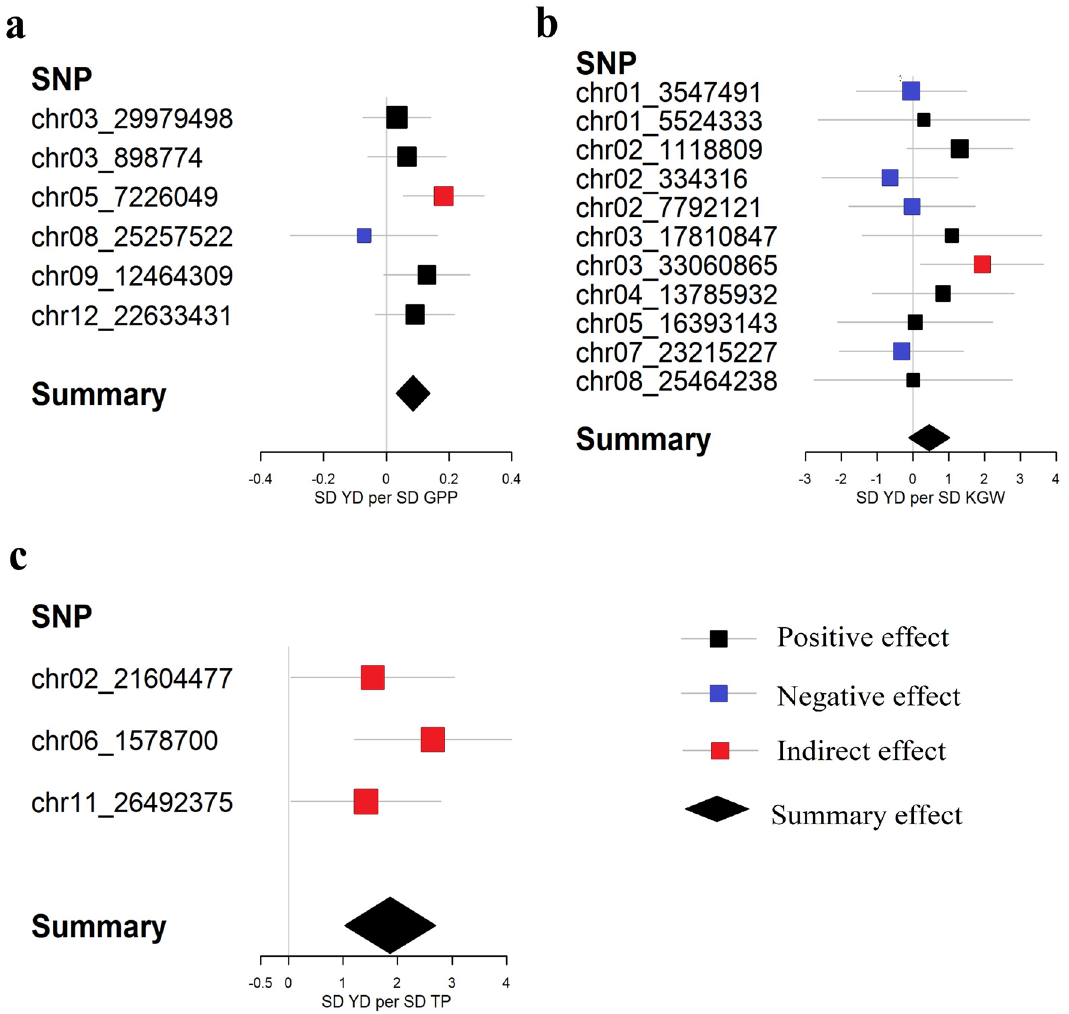
Figure 2. Genetic effect estimates of yield and its components. Estimates are derived from IVW method of MR analyses. ( a ) Effect estimates between GPP and YD. ( b ) Effect estimates between KGW and YD. ( c ) Effect estimates between TP and YD.